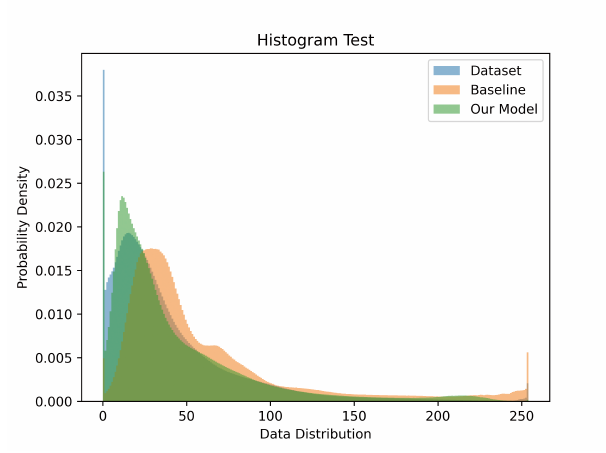
Figure 6. The normalized color histograms of the original dataset ( blue ), baseline ( orange ), and our model ( green ). Our histogram distribution is closer to the original dataset than the baseline.